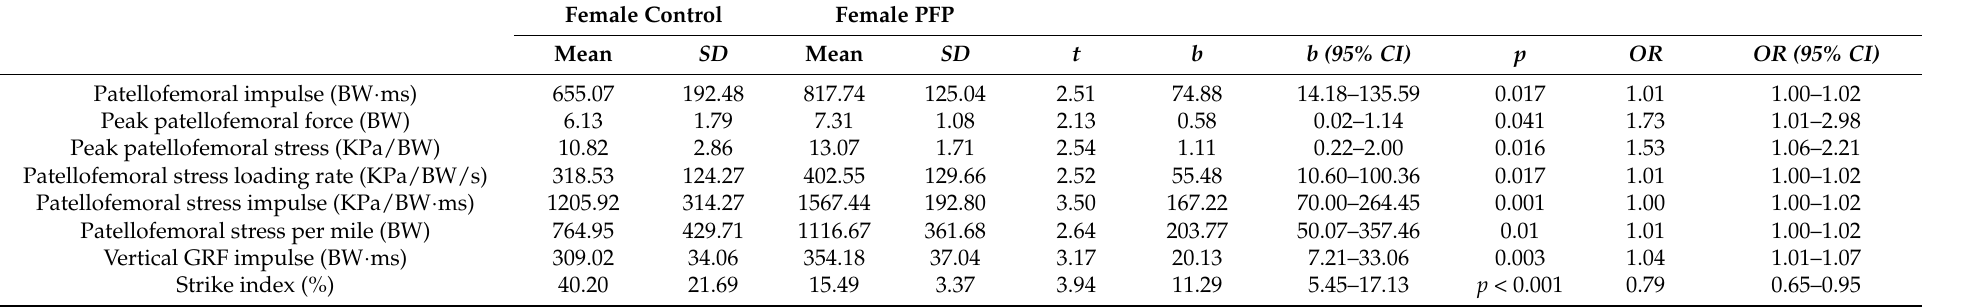
Table 8. Joint loading and temporal indices in female PFP participants and controls.